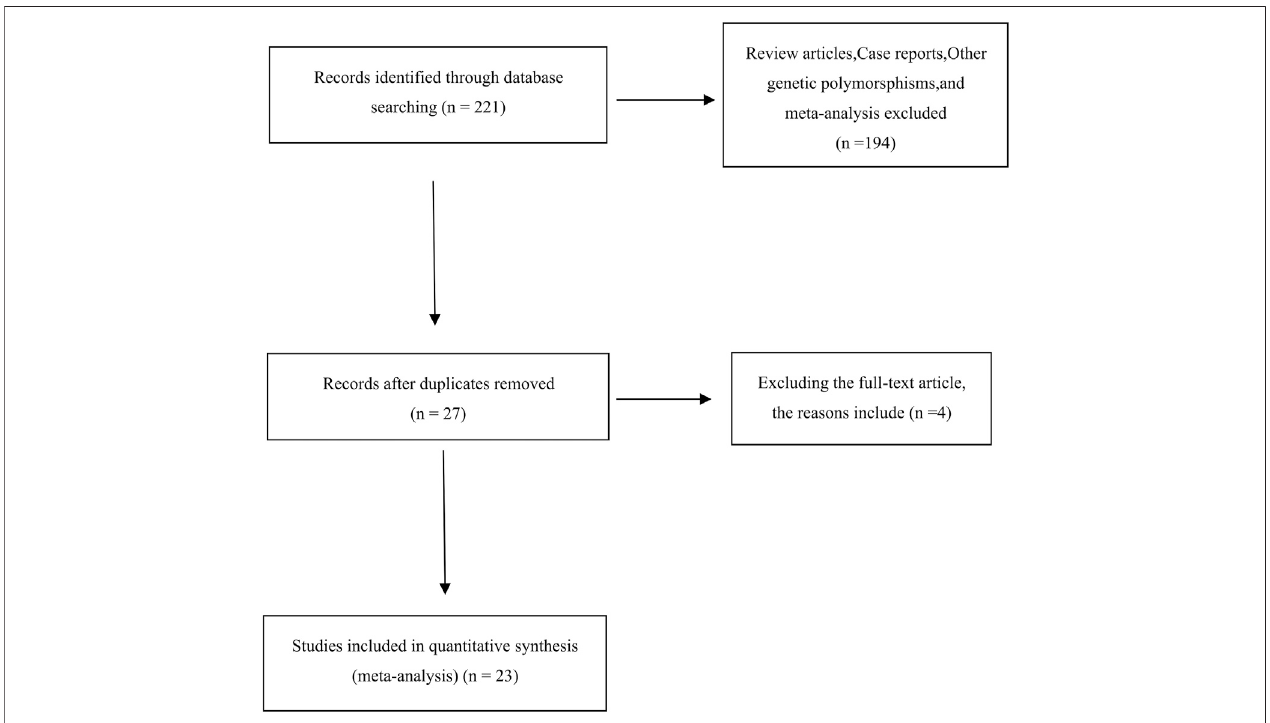
FIGURE 1 | Flow diagram of the literature